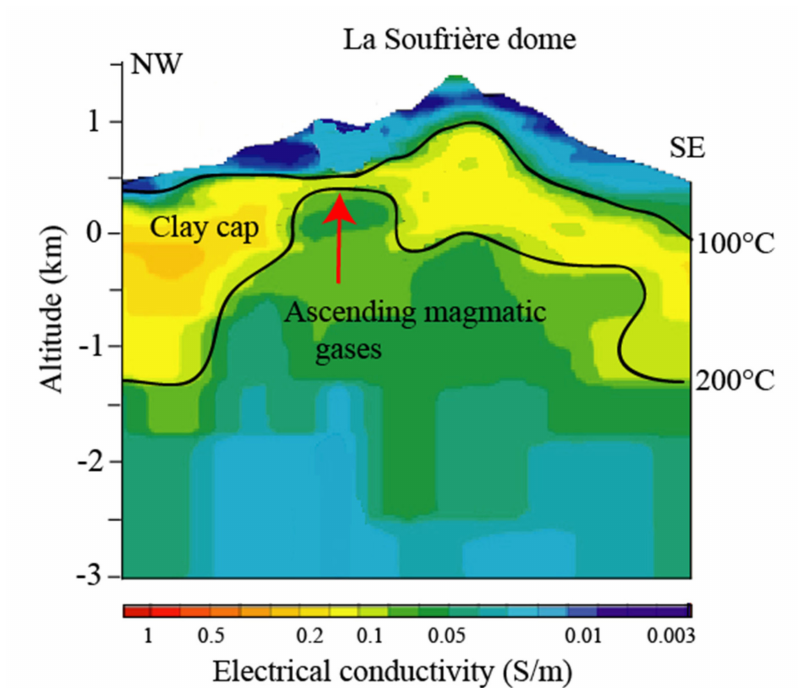
Figure 17. Detection of smectite-rich clay cap at La Soufri è re stratovolcano dome. The base of the clay cap corresponds roughly to the end of the stability temperature field of smectite (roughly 200–220 ◦ C). The conductivity profile is from Raguenel et al. [93].